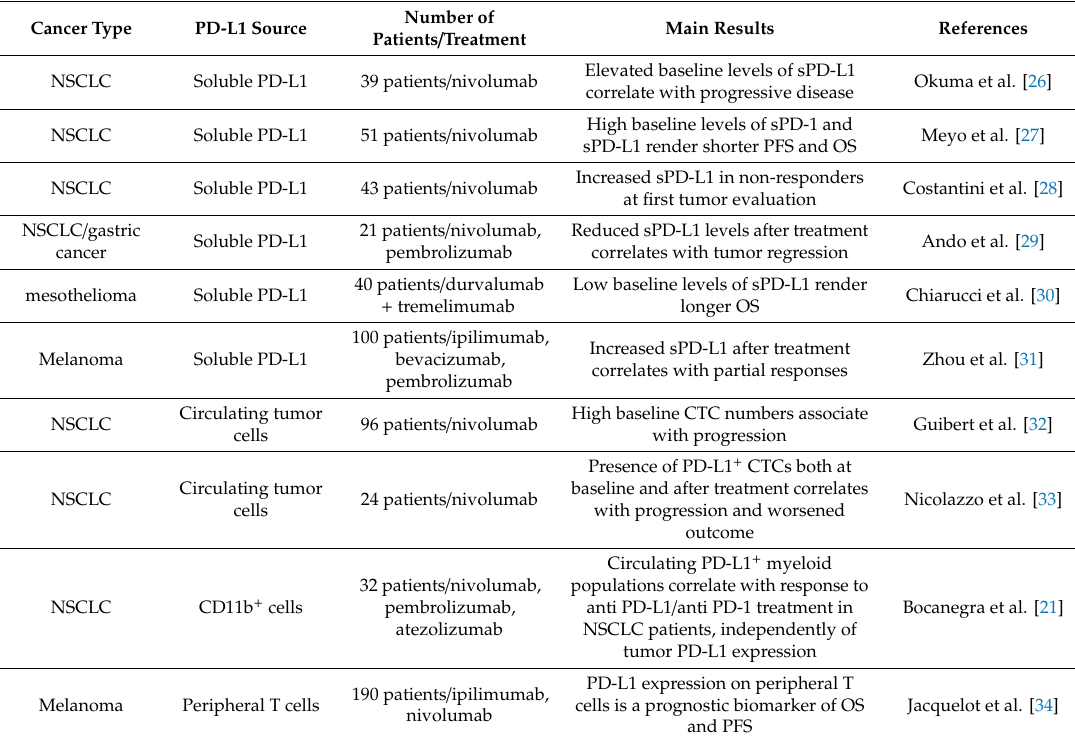
Table 1. Summary of studies on PD-L1 beyond the tumor